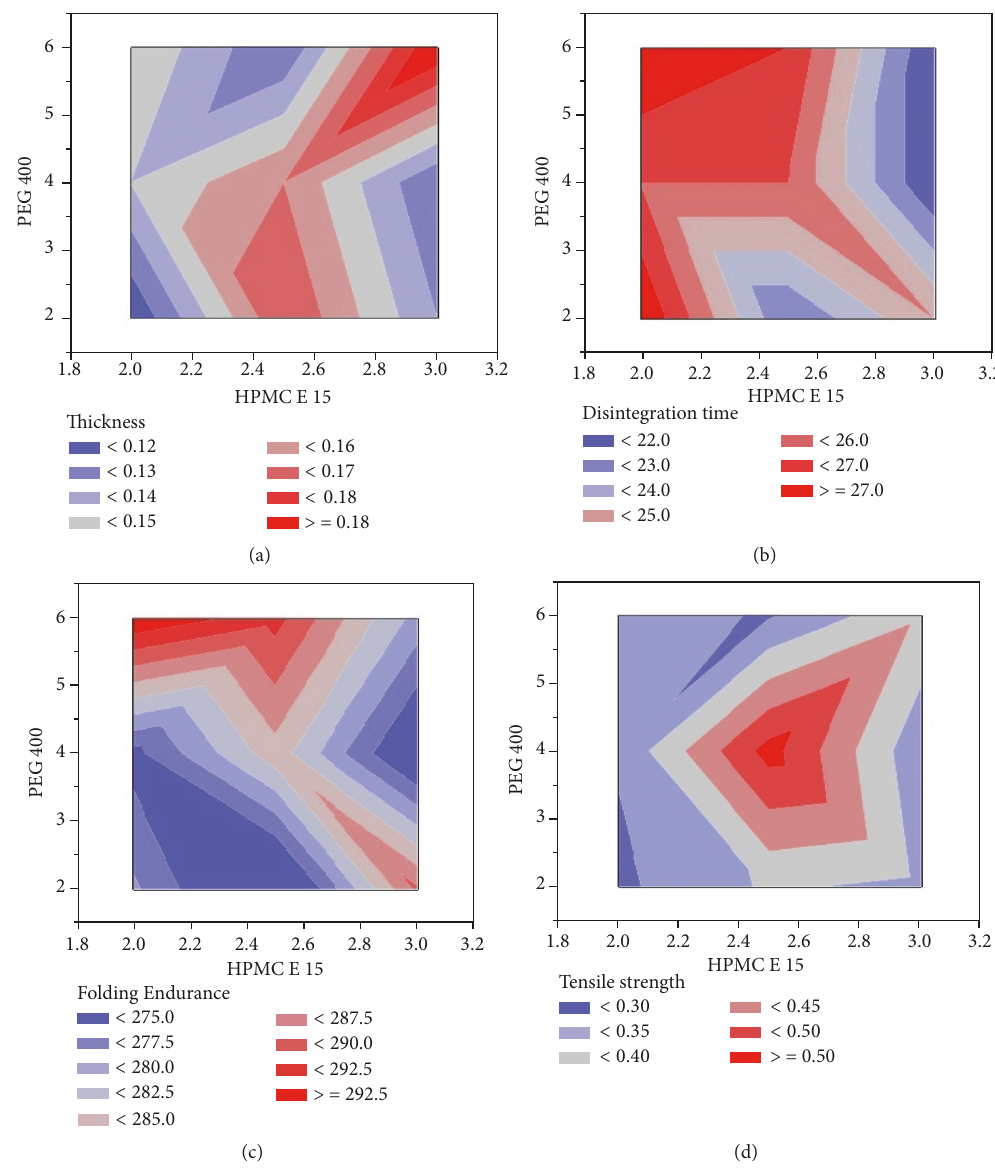
Figure 2: Counter-plot illustrating the influence of HPMC E 15 (X 1 ) and PEG 400 (X 2 ) on (a) thickness, (b) disintegration time, (c) folding endurance, and (d) tensile